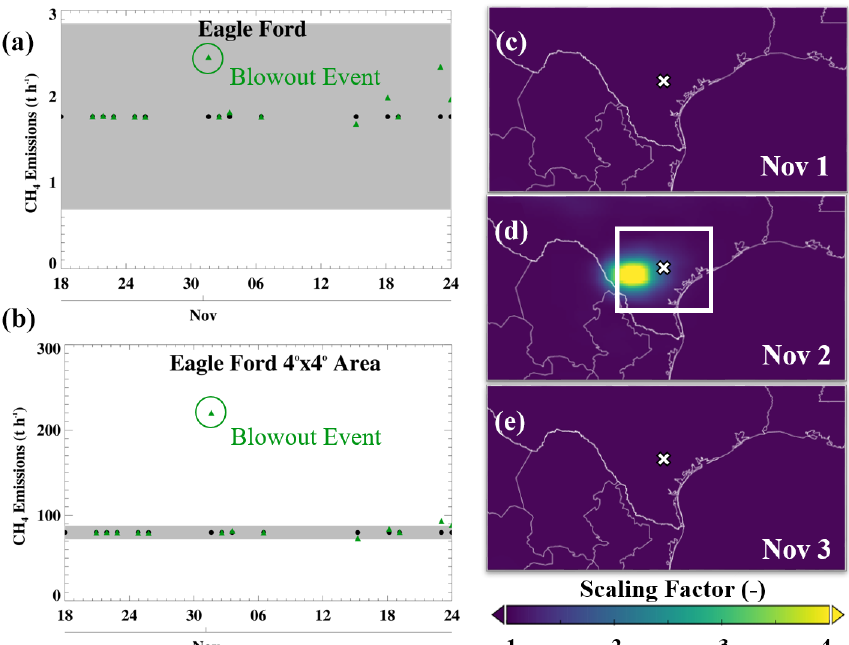
Figure 7. Prior (black circles) and posterior (green triangles) anthropogenic CH 4 emission estimates, where observations are available, over an oil well blowout event in Eagle Ford, USA, during October/November 2019 at the grid scale (a) and within a 4 ◦ × 4 ◦ domain (b) . The shaded error denotes prior uncertainty. The nearest date (2 November) to the event, which occurred on 1 November, is also indicated. Regional scaling factor values from the inversion for 1 November (c) , 2 (d) and 3 (e) . Eagle Ford blowout site marked with an “x” and 4 ◦ × 4 ◦ domain